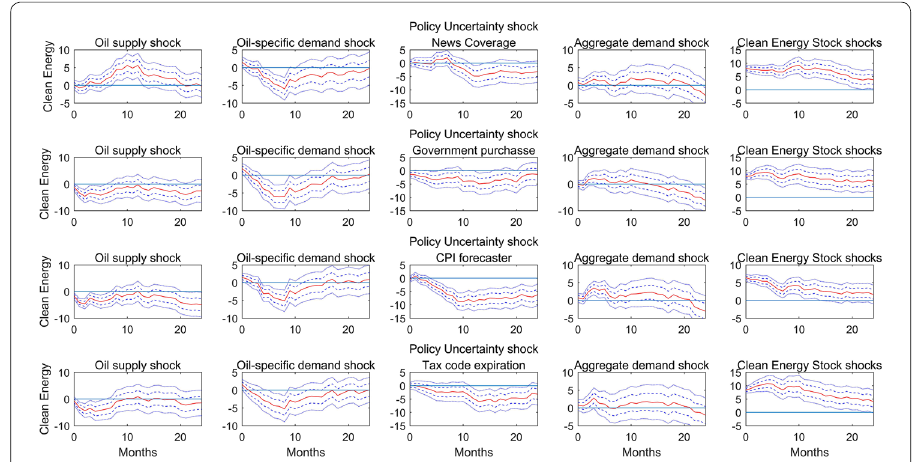
Fig. 7 Responses of clean energy industry returns to one and two standard deviation structural shocks